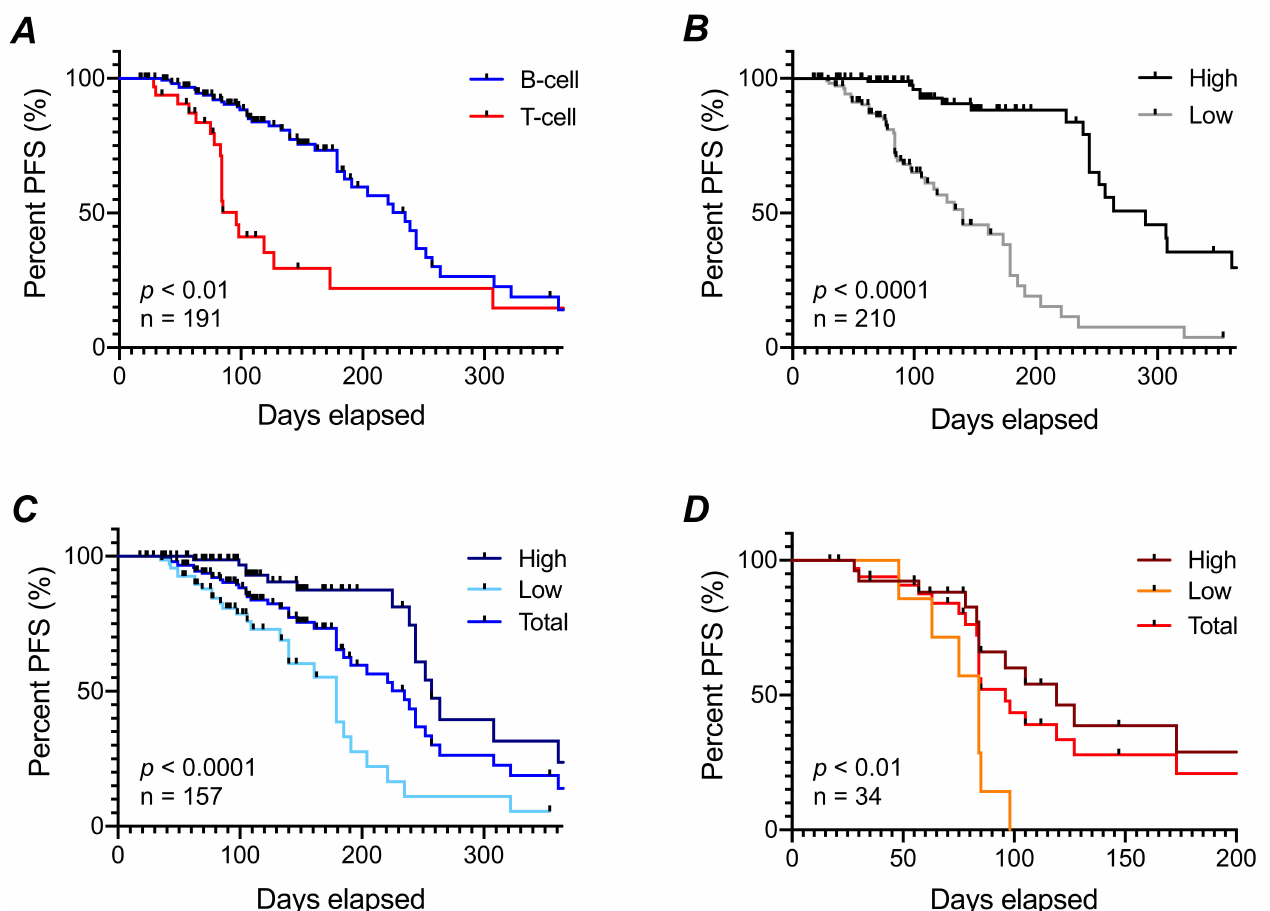
Figure 4. Application of the ML model in predicting prognosis. ( A ) Progression-free survival of B- vs. T-cell canine lymphoma patients. ( B ) The same PFS analysis based on the Cox model generated the number of days by which the probability of relapse reaches 50%; the discrepancies in n are due to some of the patients not being classified as either cell-type. The same PFS analysis using stratification based on the Cox model generated median days for the ( C ) B-cell and ( D ) T-cell subtypes among our